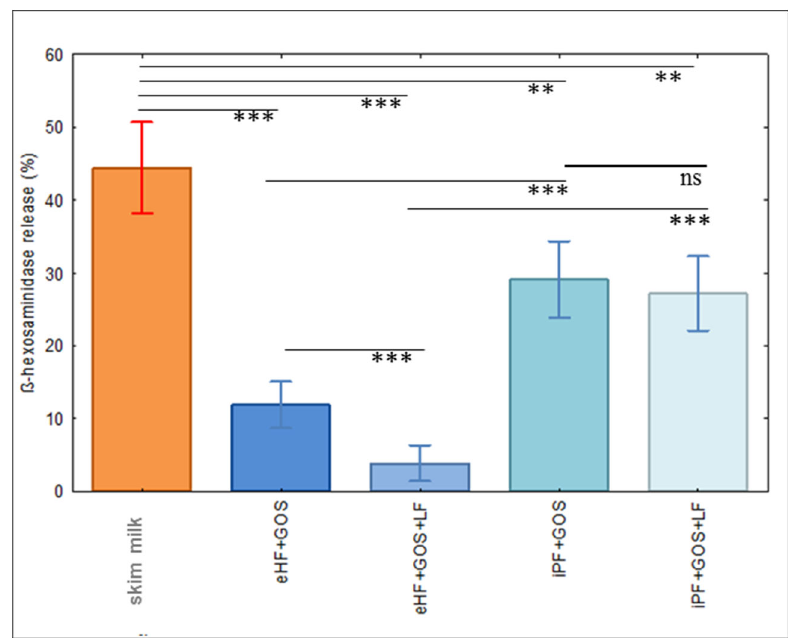
Figure 3. Specific basophil degranulation induced with milk products. Shown are the mean (n = 20) +/- SEM percentages of ß-hexosaminidase releases ( y -axis) induced by a concentration of 10 ng/mL of different milk products or infant formula ( x -axis; Table 2) from human FcεRI-expressing rat basophils that had been loaded with serum IgE from 20 different cow’s milk-allergic patients. Signifi- cant differences in mediator release induced by the milk products or infant formula are indicated. ** p ≤ 0.01, *** p ≤ 0.001, ns, not